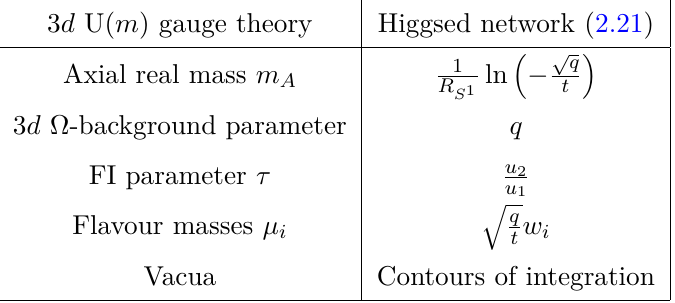
Table 1 . Dictionary between the parameters of the 3 d gauge theory and Higgsed